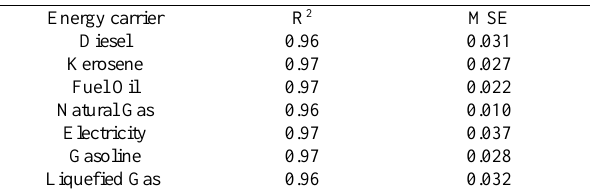
Table 7. Mean values of R 2 and MSE obtained from the ANNs for different energy